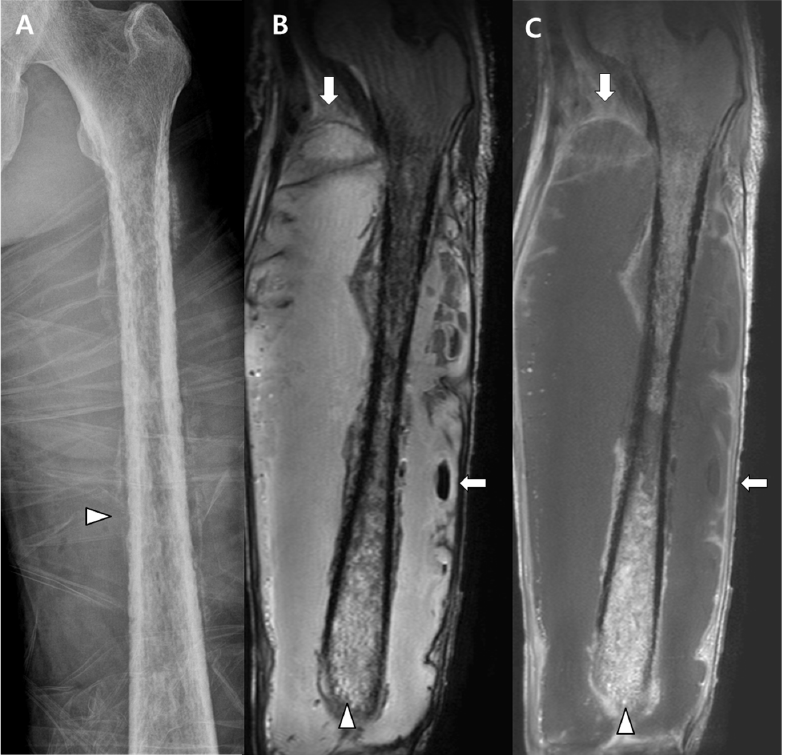
Figure 1. ( A ) Radiography of the left lower extremity shows periosteal thickening with osteolysis (arrowheads), which is compatible with osteomyelitis. ( B , C ) Coronal T2-weighted and T1 contrast enhancement MRI scans show extensive soft tissue abscess (arrows) with associated abnormal marrow signal intensities (arrowheads) representing pyomyositis with osteomyelitis.